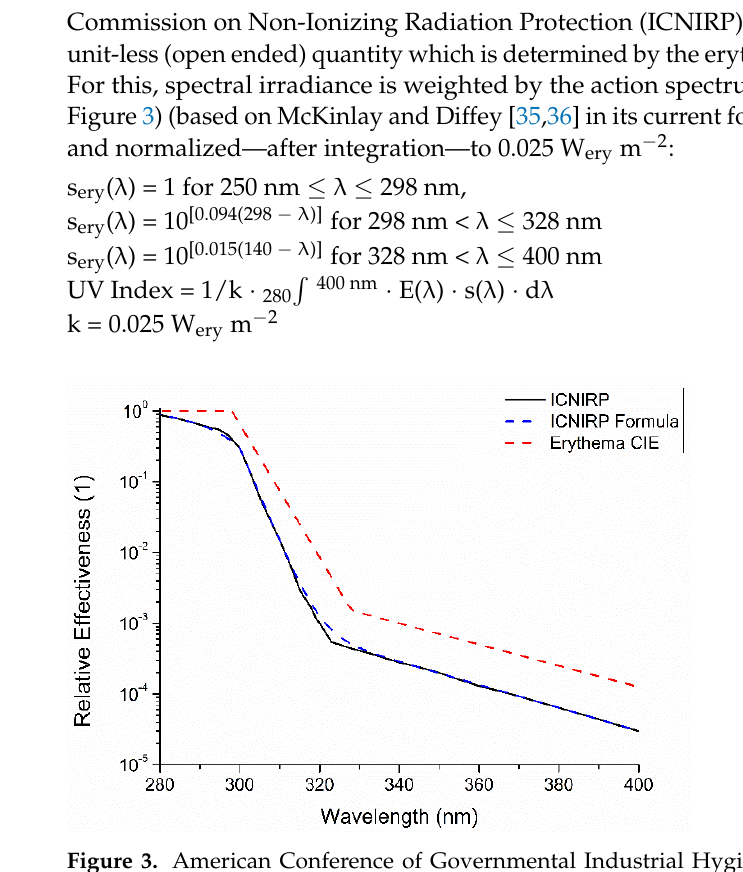
Figure 3. American Conference of Governmental Industrial Hygienists (ACGIH)/International Commission on Non-Ionizing Radiation Protection (ICNIRP) action spectrum according published tabled values [81]) (black line) and according the provided formula (blue dashed line) [82]. For comparison, the action spectrum of erythema according ISO (International Standards Organization) /CIE [32,80]) is shown (red dashed line).